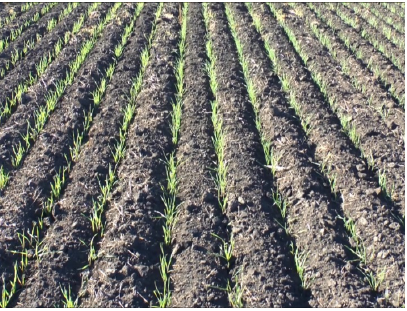
Figure 20. Sprouts of grain crops after sowing with the PK- 12.7